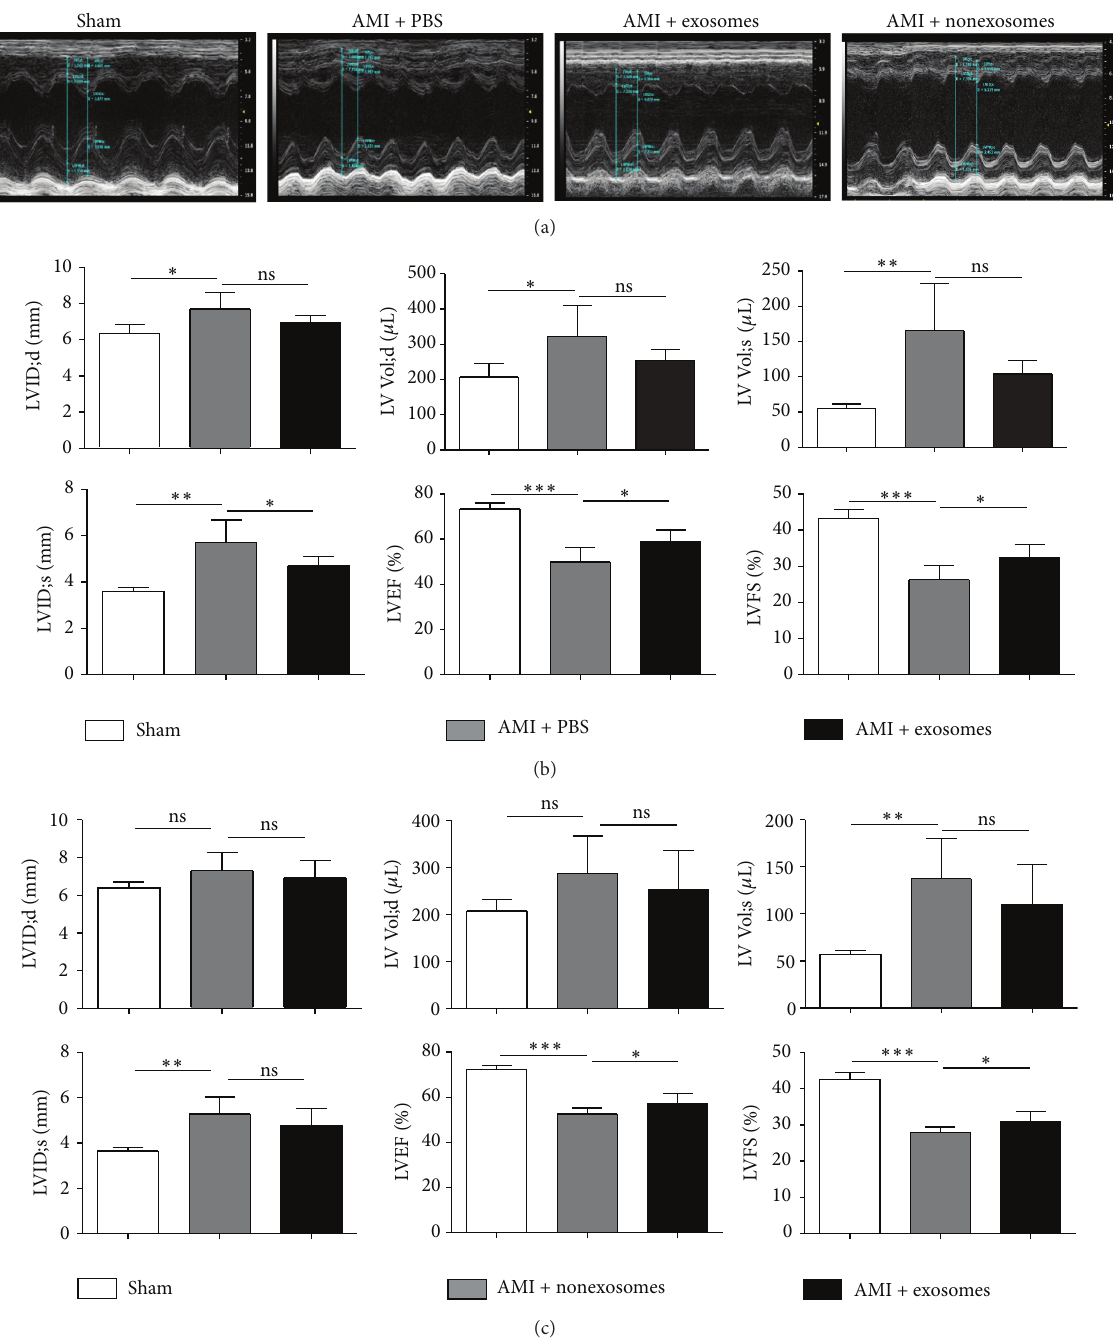
Figure 4: hucMSC-exosomes improved the cardiac systolic function of AMI rats 4 weeks after exosomes infusion. Echocardiographs (a). Cardiac function related parameters (LVEF, LVFS, LVID;s, LVID;d; LV Vol;d, and LV Vol;s) in hucMSC-exosomes (b) and in hucMSC-CM without exosomes treated animals (c). ∗ 𝑃 < 0.05 , ∗∗ 𝑃 < 0.01 , and ∗∗∗ 𝑃 < 0.001 ; ns: no significant difference between the two groups.